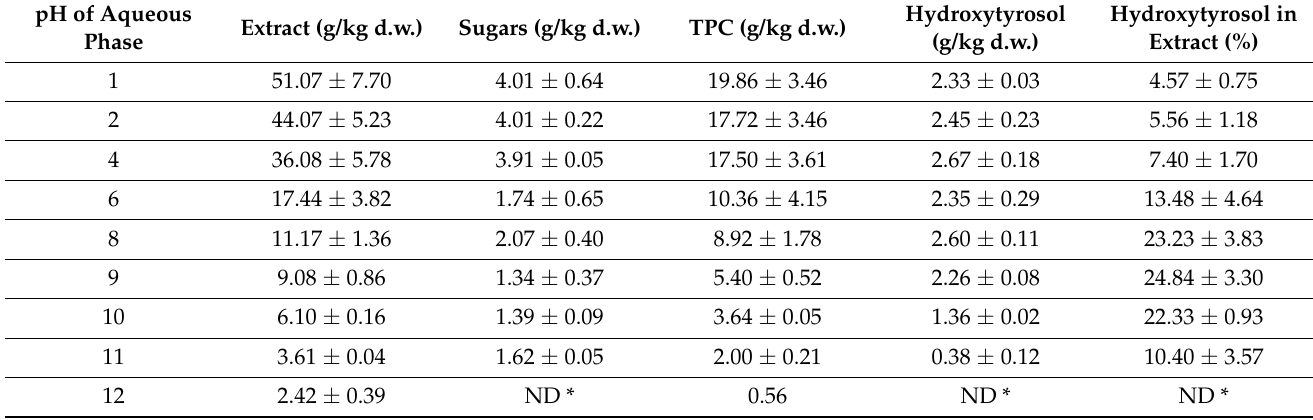
Table 3. Effect of the pH of the aqueous phase on the recovery of different